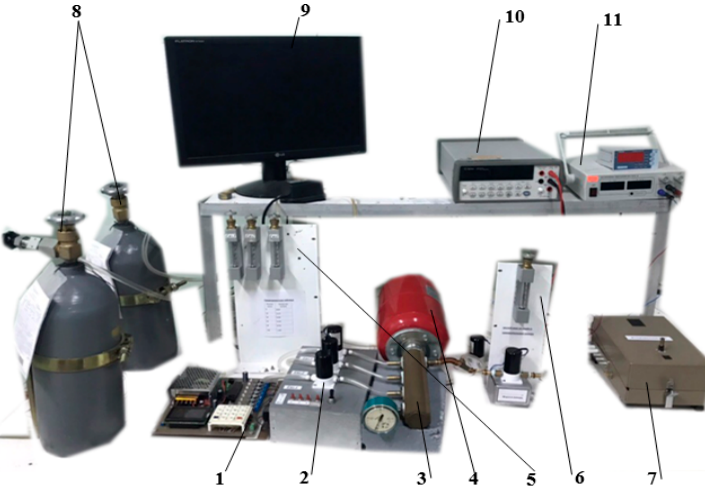
Figure 2. An automated stand for calibrating gas sensors: an electronic control unit for the gas distribution system (1), solenoid valves (2), a mixing chamber (3), a container for a mixture of gases (4), a flow control unit for the source gas components (5), a control unit a gas mixture stream (6); measuring chamber (7); cylinders with original gas components (8), personal computer (9), multimeter (10), power supply (11).